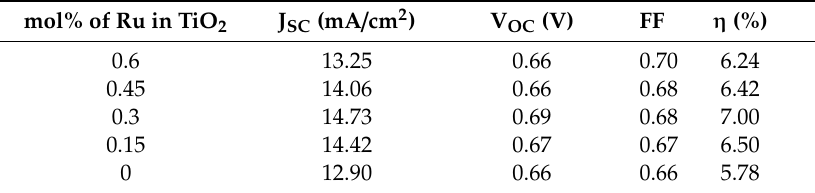
Table 2. Current-voltage (J–V) characteristics of the DSSCs assembled with di ff erent mol% Ru-doped P25-TiO 2 photoanodes and its control P25-TiO 2 photoanodes.